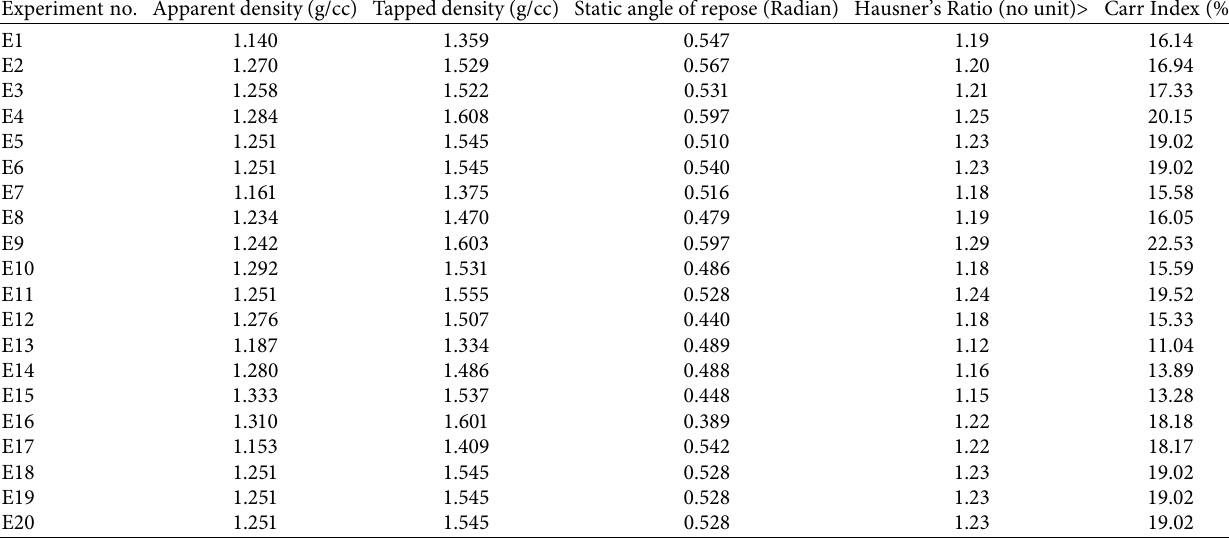
Table 3: Output responses based on CCD-based